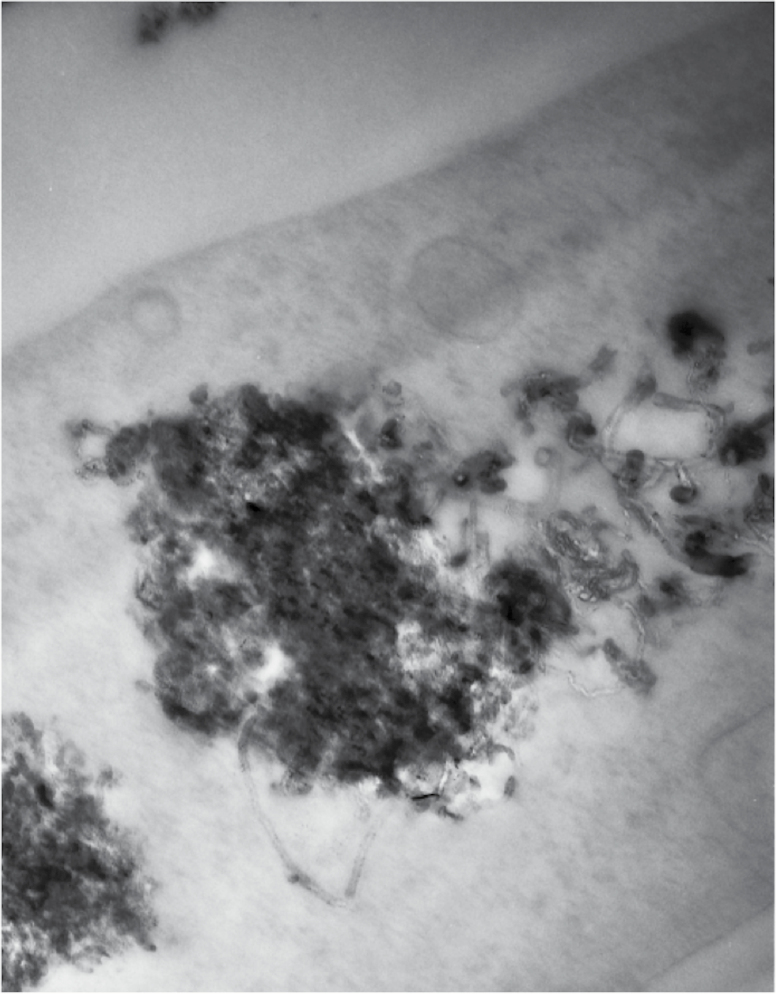
Transmission electron micrograph of a clump of nanotubes within the cytoplasm of a cell. Individual MWNTs are visible projecting from edges of the clump. The micrograph shows how large quantities of nanotubes can be internalised and accumulated within the cell cytoplasm.